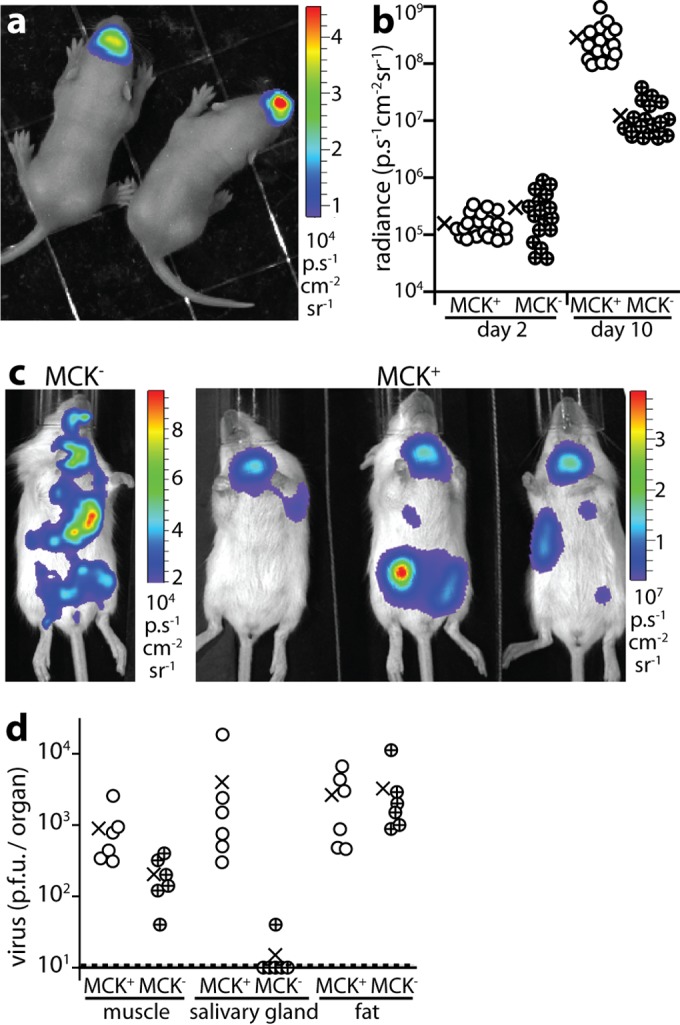
MCK2 is redundant for MCMV nasal infection but not for subsequent spread. (a) BALB/c pups imaged 2 days after i.n. MCK2− MCMV-LUC (3 × 104 PFU). The image shown is representative of the images for 16 mice. (b) Live images showed no i.n. infection defect of MCK2− MCMV-LUC at day 2 but significantly less disseminated signal than MCK2+ infected controls at day 10 (P < 0.001). The circles represent values for individual mice. The means are indicated by × symbols. (c) Live imaging after day 10 showed dissemination but little salivary gland infection by i.n. MCK2− MCMV compared to MCK2+. Note the different image scales. The images shown are representative of the images for six mice. (d) Plaque assays 10 days after i.n. inoculation showed significantly less MCK2− MCMV than MCK2+ MCMV in salivary glands (P < 0.01) but not in muscle (P = 0.08) or fat (P = 0.8). The circles represent values for individual mice. The means are indicated by × symbols.